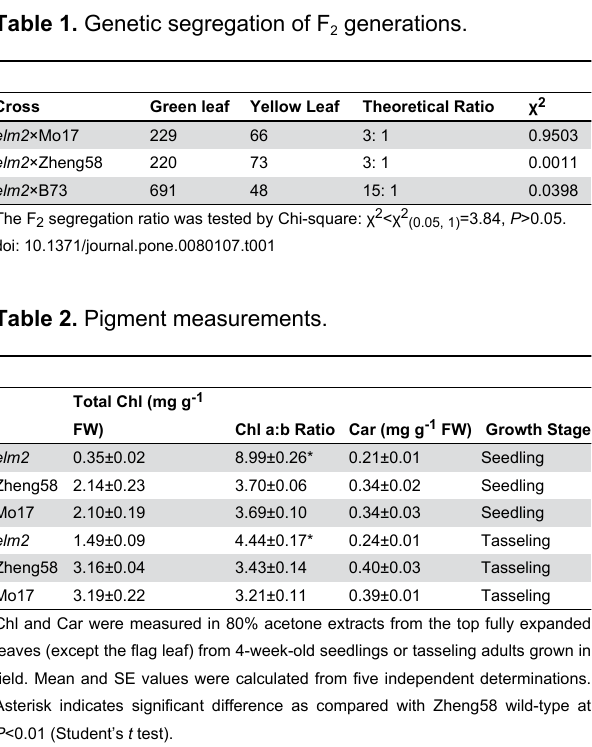
Table 1. Genetic segregation of F